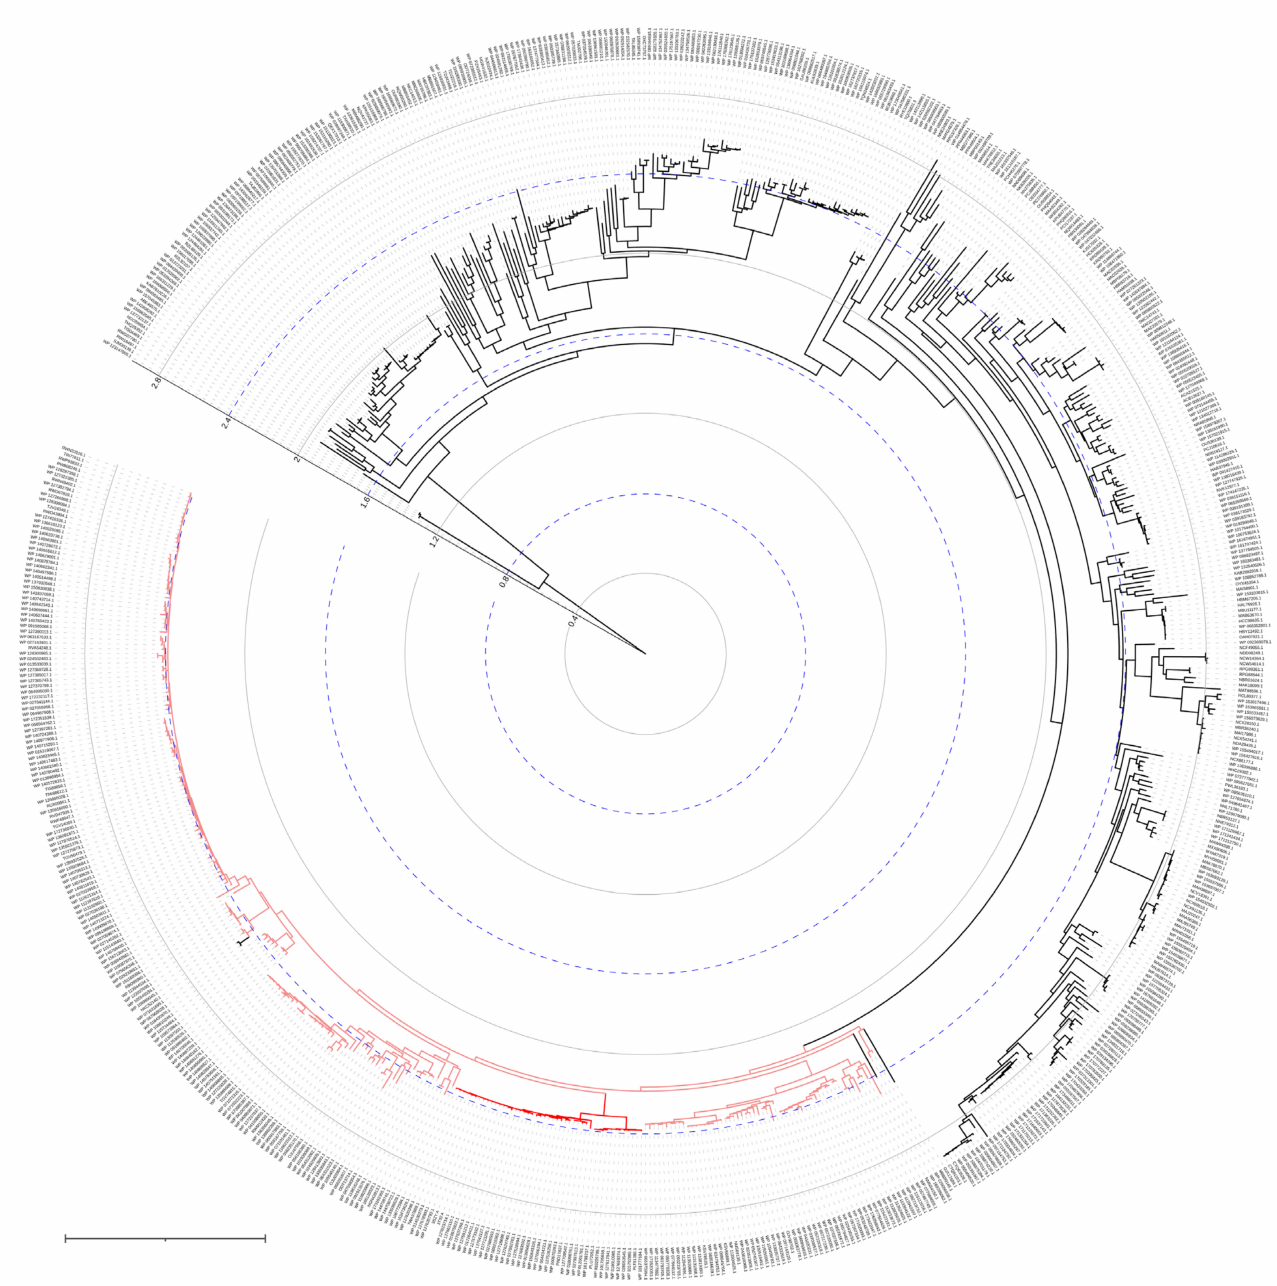
Figure 19. Phylogenetic tree of PhnA and its homologous enzymes (down to 44% identity). The tree was built as previously with PDB 3SZY as a reference sequence. Enzymes having high (90–100%) and good (80–89%) identity are highlighted with red and pink,